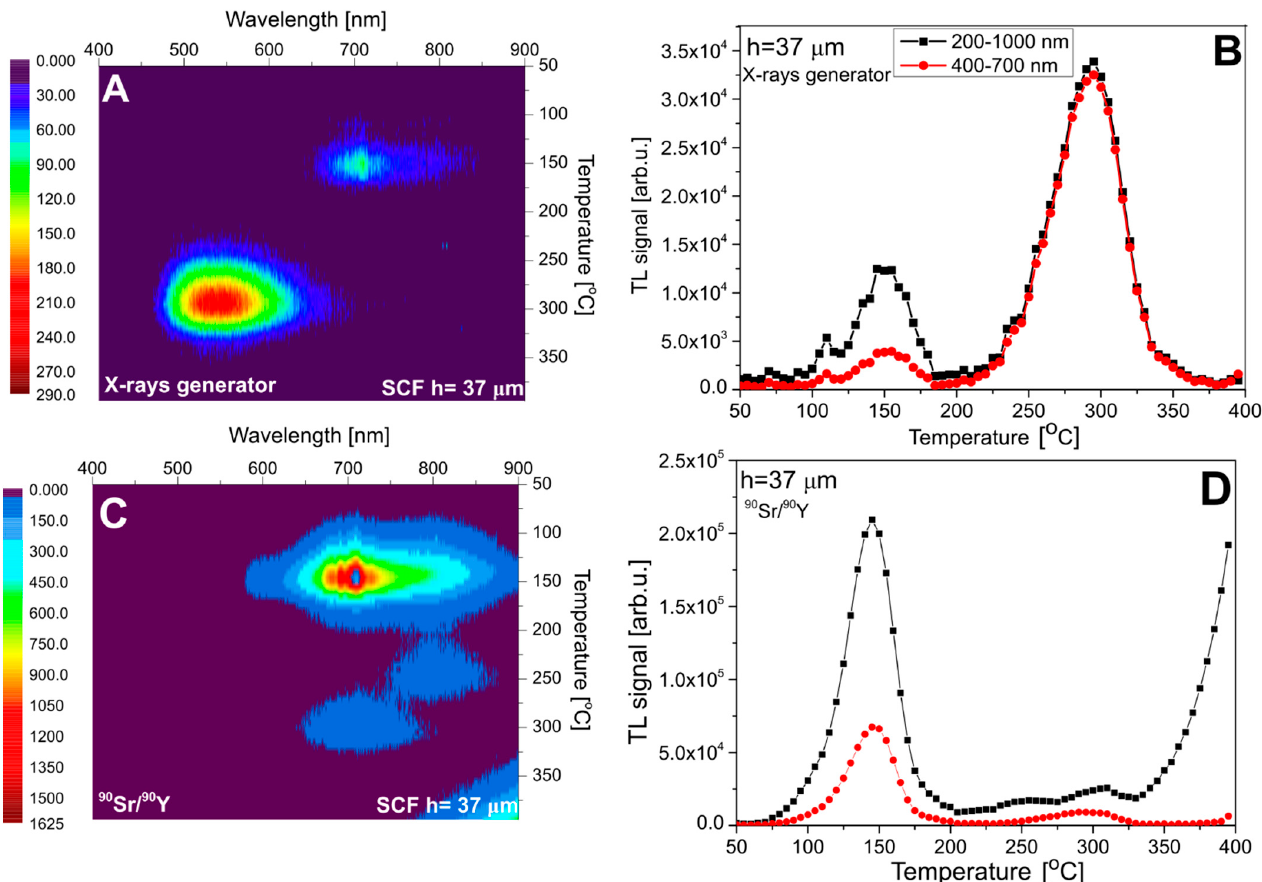
Figure 8. The emission spectra of sample #2 ( panel A —after irradiation with 15 kV X-rays and panel C —after irradiation with 90 Sr/ 90 Y) and TL glow curves ( panels B , D ). TL glow curves are taken from the spectral measurements.